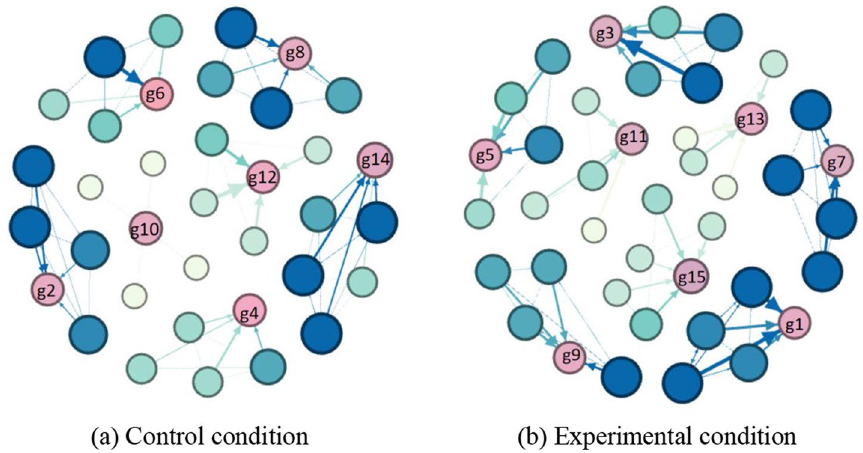
Fig. 4 Social interaction network plots under two conditions. The node size represented interaction frequencies, the edge thickness represented the interaction frequencies that a student had to another student or the group; the node in blue represented one group member, the node in pink represented the whole group rather than one group member